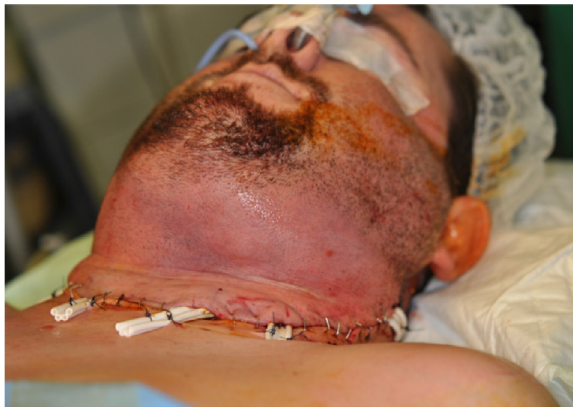
Fig. 5. Immediate postoperative